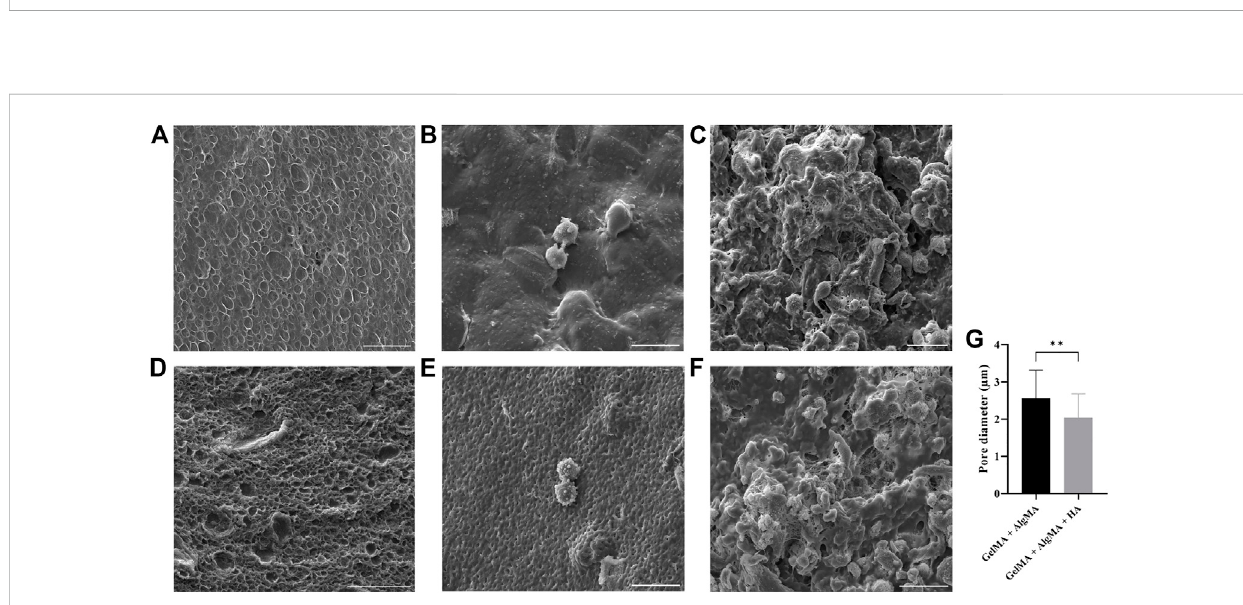
FIGURE 3 canning electron microscopy (SEM) of the hydrogels. GelMA + AlgMA without cells (A) on day 1 (B) and day 15 of culture (C) ; GelMA + AlgMA + HA without cells (D) on day 1 (E) and on day 15 (F) (scale bar 20 µm); quanti fi cation of the pore diameter of both formulations (G) . Data are presented as mean ± standard deviation. Unpaired t -test statistical analysis performed: ** = p <